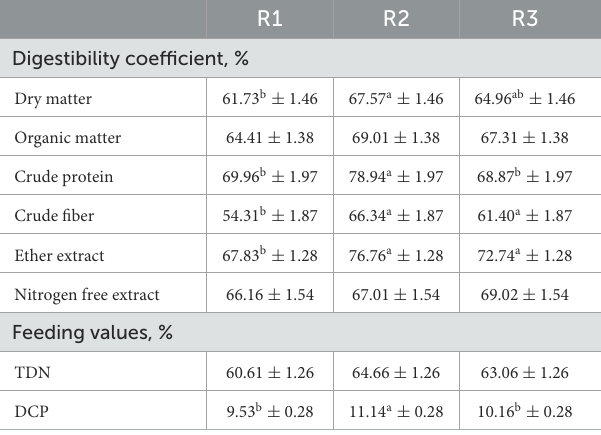
TABLE 5 Blood biochemical constituents affected by feeding sun-dried azolla meal in rations of Zaraibi dairy goats.